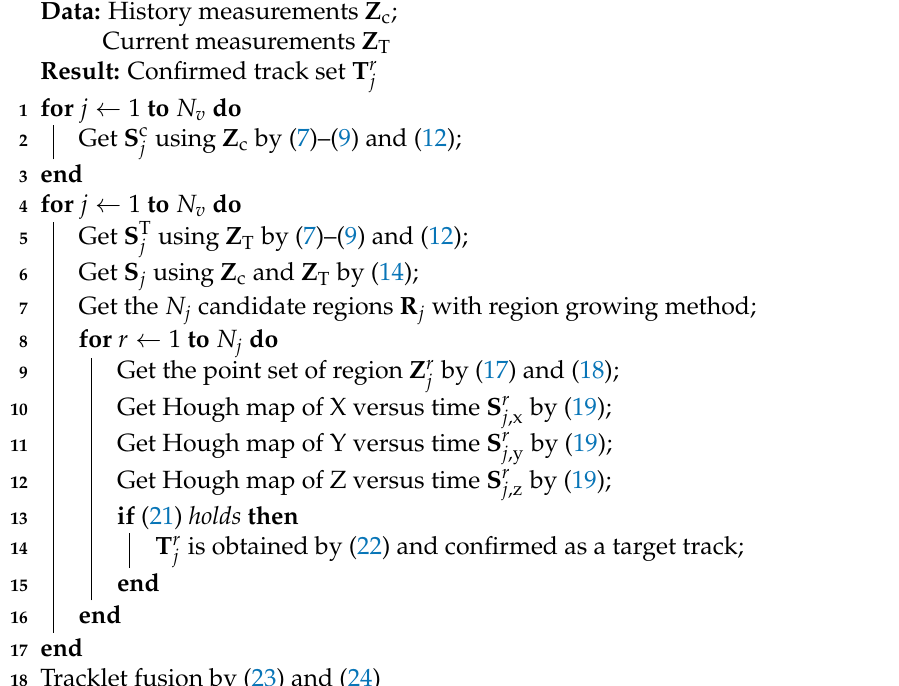
Algorithm 1: The 4D Track-before-detect